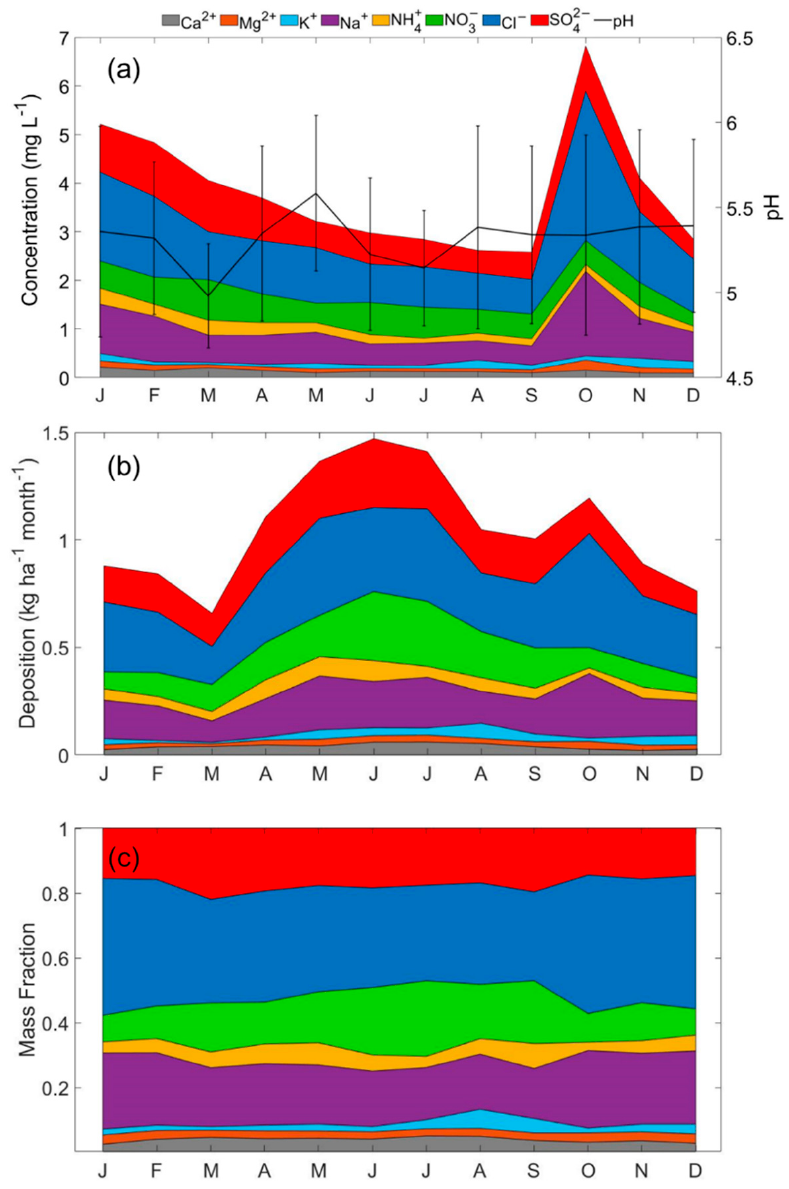
Figure 6. Monthly averaged ( a ) precipitation-weighted ion concentrations and pH, ( b ) wet deposition fluxes, and ( c ) mass fractions.